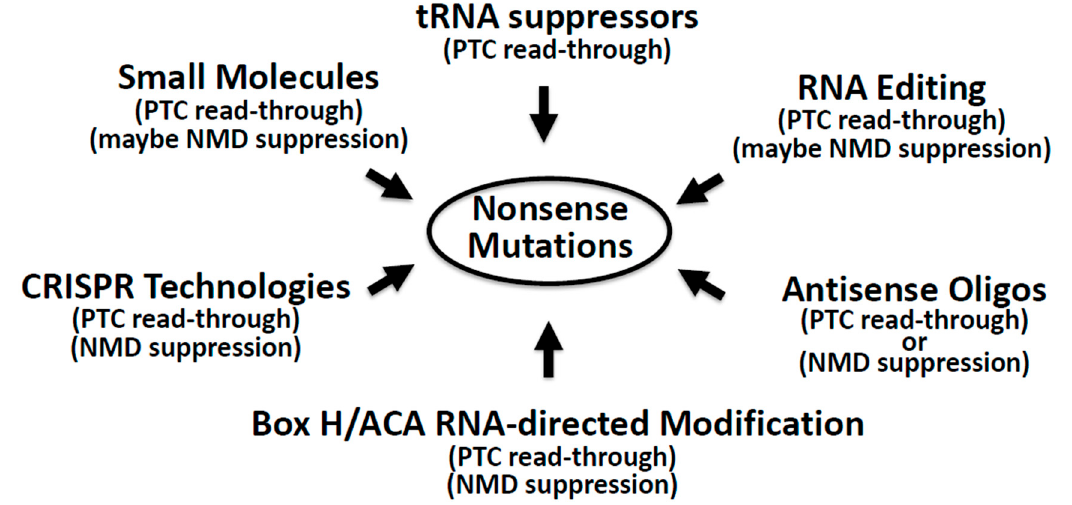
Figure 2. Nonsense suppression by various approaches. A number of approaches (indicated) are developed to suppress nonsense mutations. Some can suppress either NMD or translation termination, while others can suppress both (indicated).